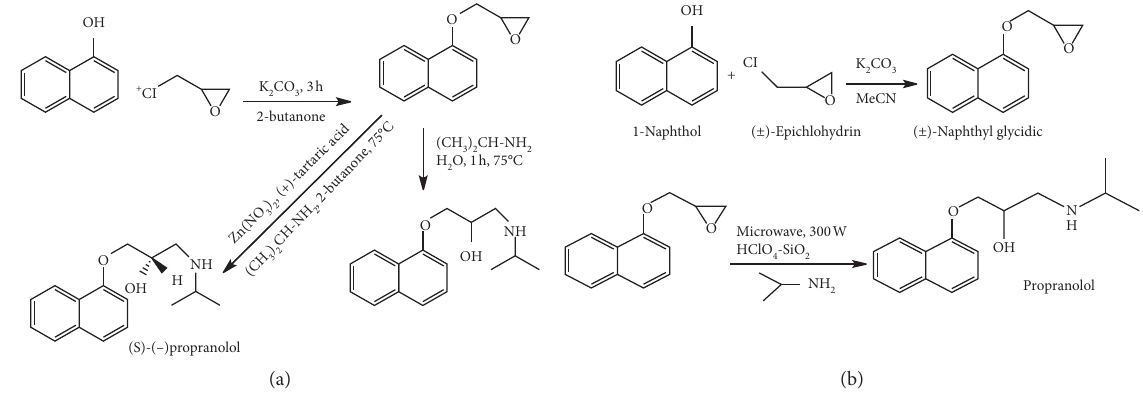
Figure 7: (a) Synthesis of propranolol used a catalyst of tartaric acid and metal salts; (b) ring opening of epoxides employing thiophenol under microwave conditions and synthesis of propranolol using silica perchloric acid